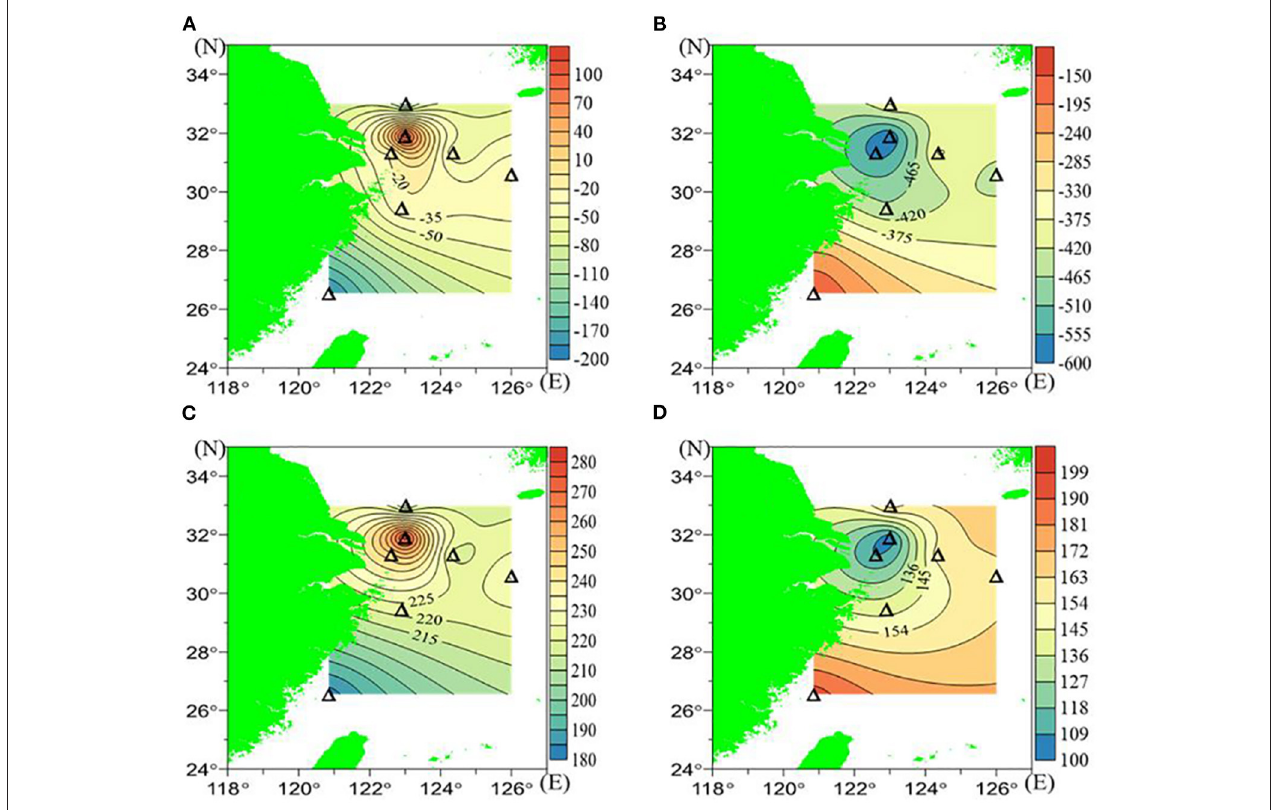
FIGURE 3 | The δ O 2 /Ar ( ‰ ) and [O 2 ] ( µ mol/L) calculated based on δ O 2 /Ar in July 2018: (A) surface δ O 2 /Ar, (B) bottom δ O 2 /Ar, (C) calculated surface [O 2 ], and (D) calculated bottom [O 2